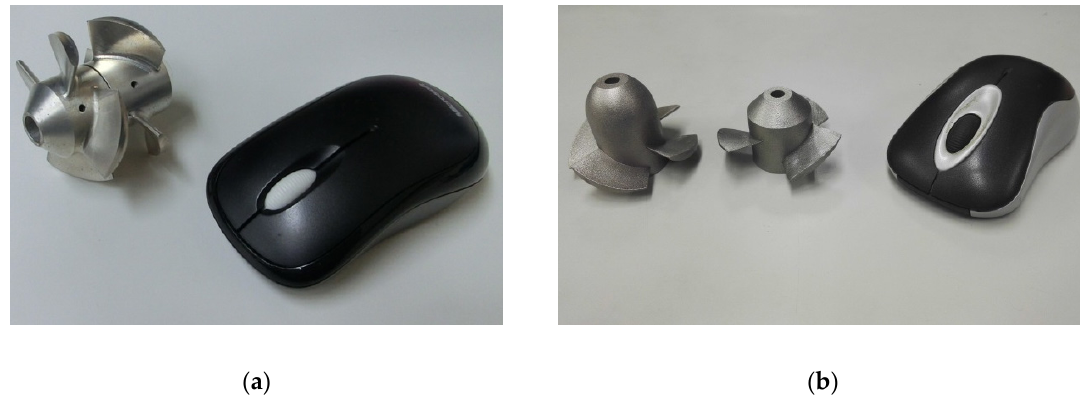
Figure 1. The original test turbine and new test turbine of contra ‐ rotating small hydro ‐ turbine. ( a ) Original test turbine. ( b ) New test turbine. Table 1. Basic parameters of the original model.